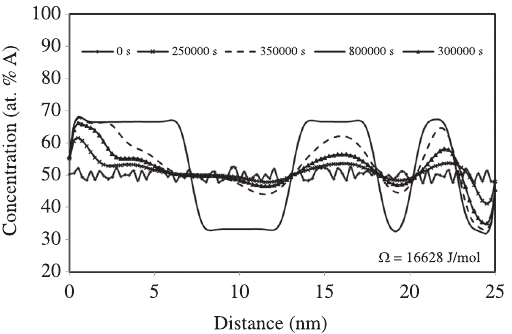
= 16628 J/mol with nonlinear A-B